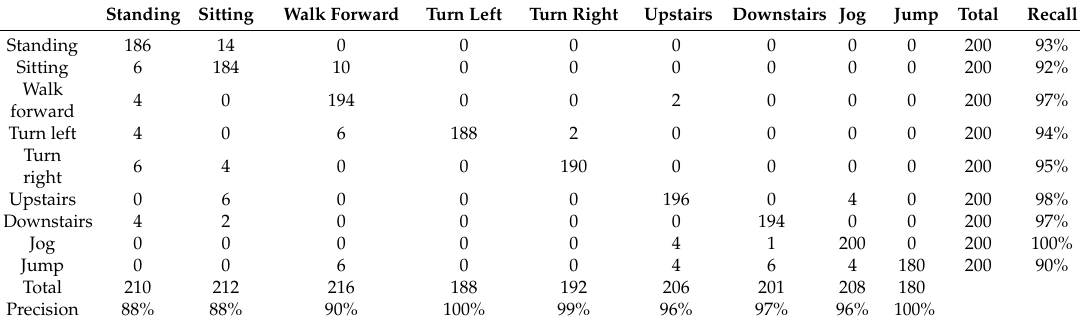
Table 5. The confusion table for classification of the nine different gait pattern classes.